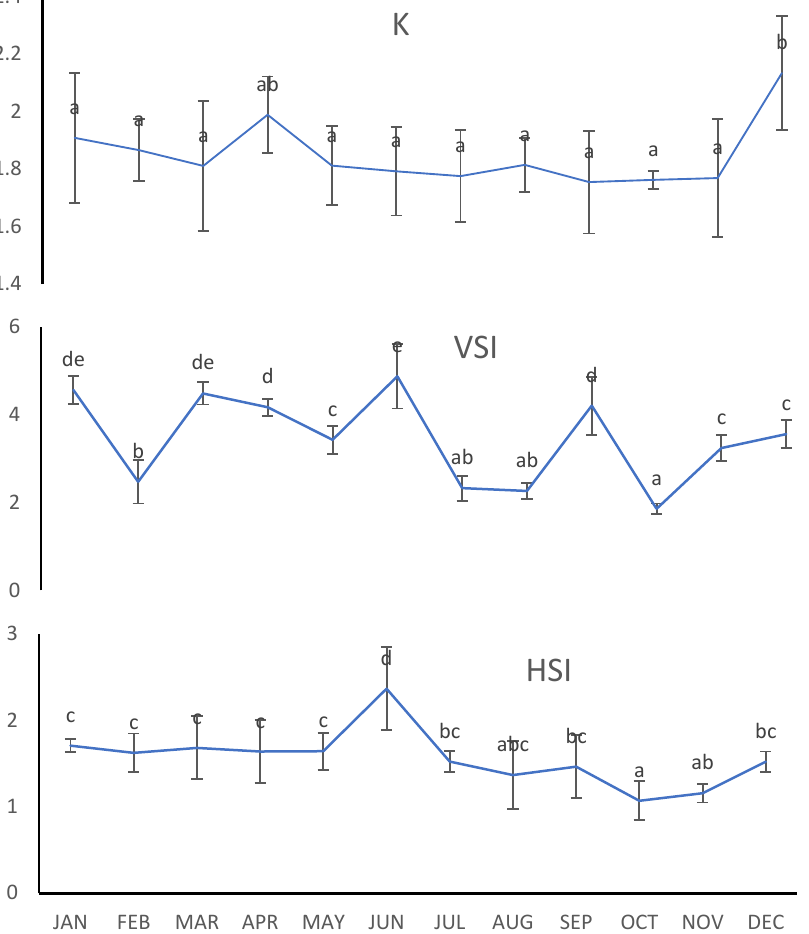
Figure 3. Monthly variation of K, VSI, and HSI (VSI: viscera somatic index, HSI: hepatosomatic index, K: condition factor). Different superscripts indicate significant difference at p < 0.05.